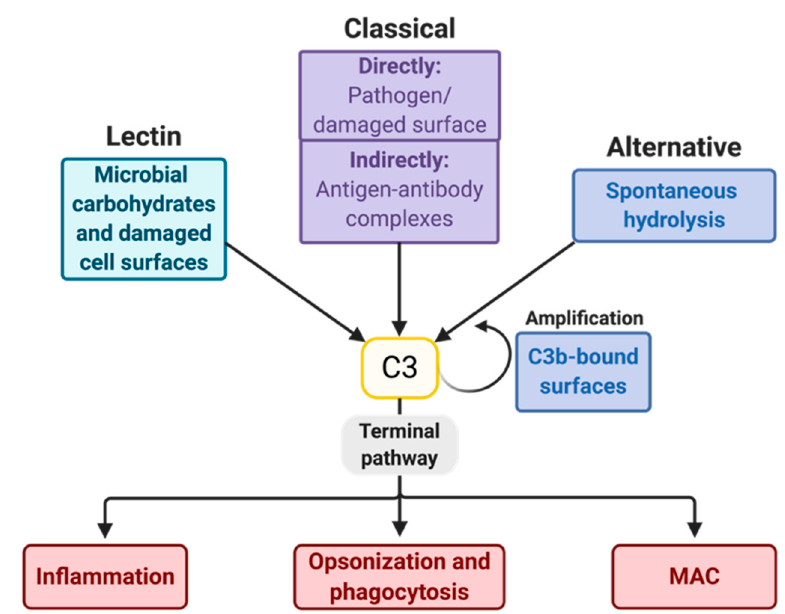
Figure 1. Pathways of the complement system. Many surfaces of pathogens, immune complexes, or modified host surfaces (e.g., necrotic and apoptotic cells [10,11]) activate the complement system. In the lectin pathway (LP), microbial carbohydrates or modified self surfaces [12] are recognized by lectins, either by one of the two collectins, mannose-binding lectin (MBL) or collectin-LK, or by one of three ficolins [13]. C1q is the recognition component of the classical pathway (CP) and recognizes either deposited immunoglobulins (Igs) or C-reactive protein [14], or binds the pathogen or apoptotic cell directly [10]. Complement component 3 (C3) may also be activated through spontaneous hydrolysis of its thioester in the alternative pathway (AP). The AP can also amplify C3-responses via the formation of a C3-convertase. The cleavage of C3 initiates the terminal pathway (TP), which introduces inflammation, opsonization, and subsequent phagocytosis as well as the formation of the membrane-attack complex (MAC). The MAC stimulates certain signaling pathways [15–18] or lyses cells to disturb their integrity. AP, alternative pathway. C3, complement component 3. CP, classical pathway. Ig, immunoglobulin. LP, lectin pathway. MAC, membrane-attack complex. TP, terminal pathway.